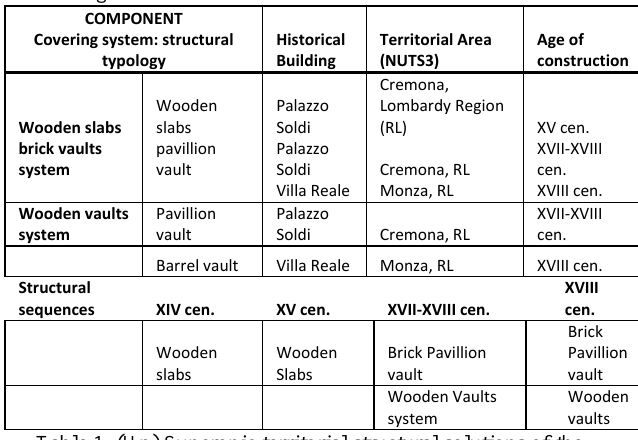
Table 1. (Up) Syncronic territorial structural solutions of the built heritage analyzed. (Down) Diacronic sequences of the structural